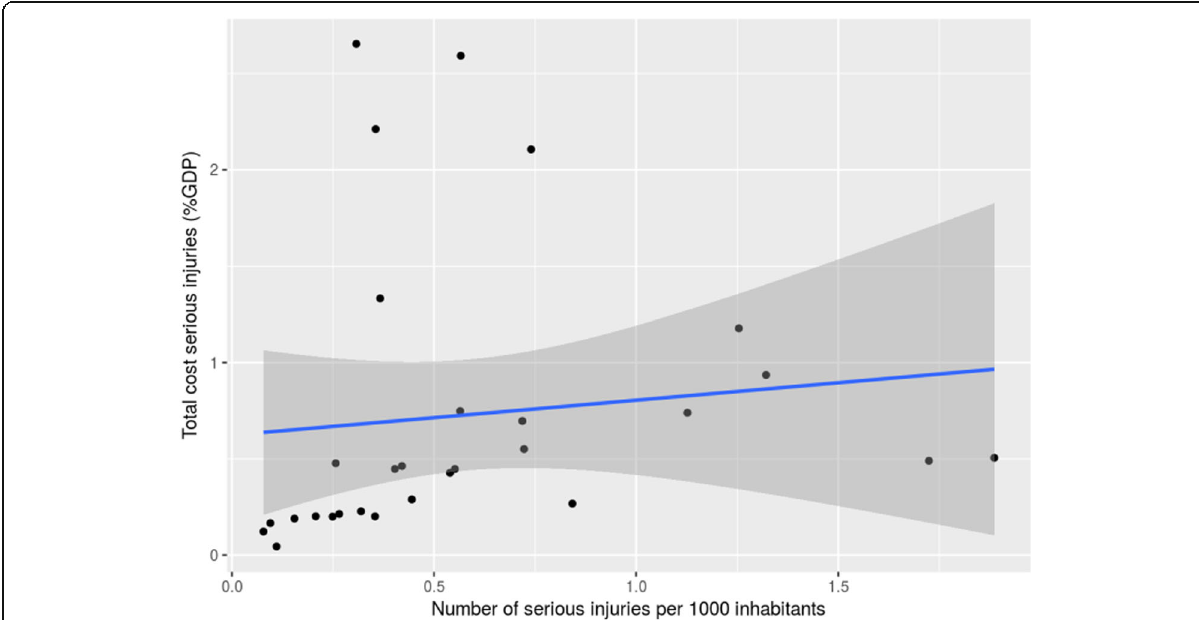
Fig. 5 Relation between number of serious injuries per million inhabitants, and total costs related to serious injuries as percentage of GDP (outliers are